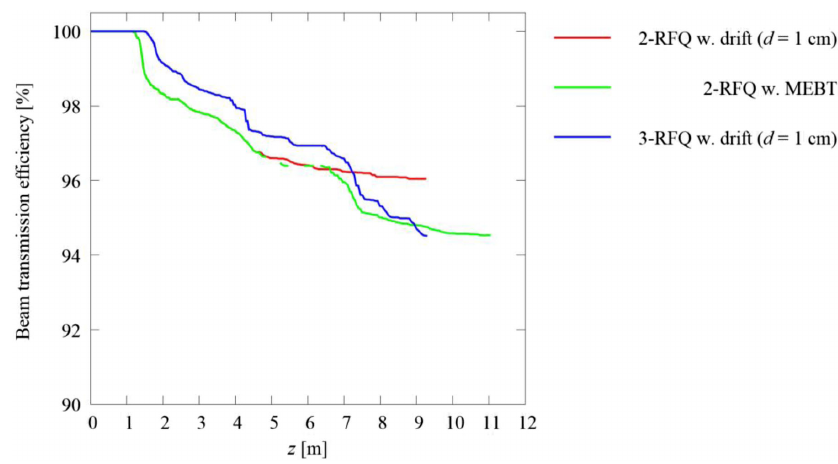
FIG. 17. Evolution of the beam transmission for the three reference